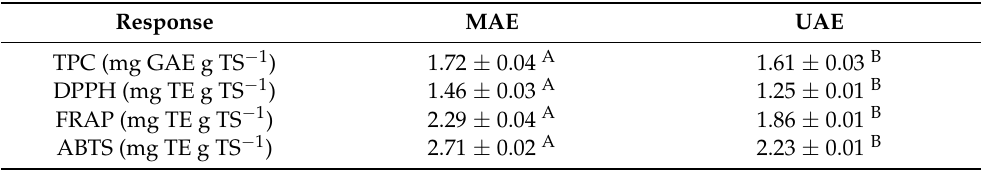
Table 5. Characterization of TSE obtained under optimum MAE and UAE conditions ( n = 3; mean ± SD). Different superscripts within the same row indicate significant differences between extracts ( p <